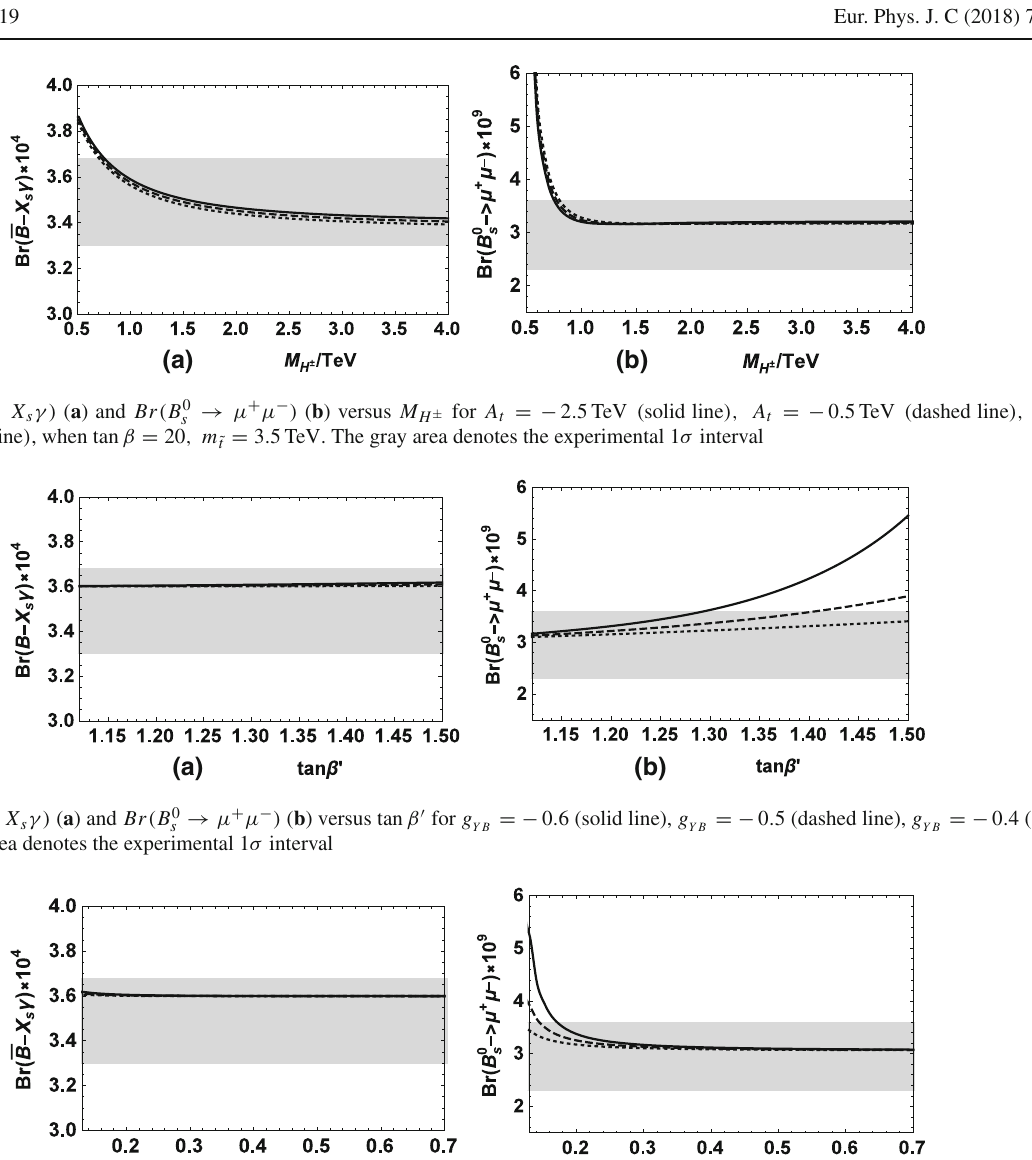
= − 0 . 5 ( dashed line ), g YB